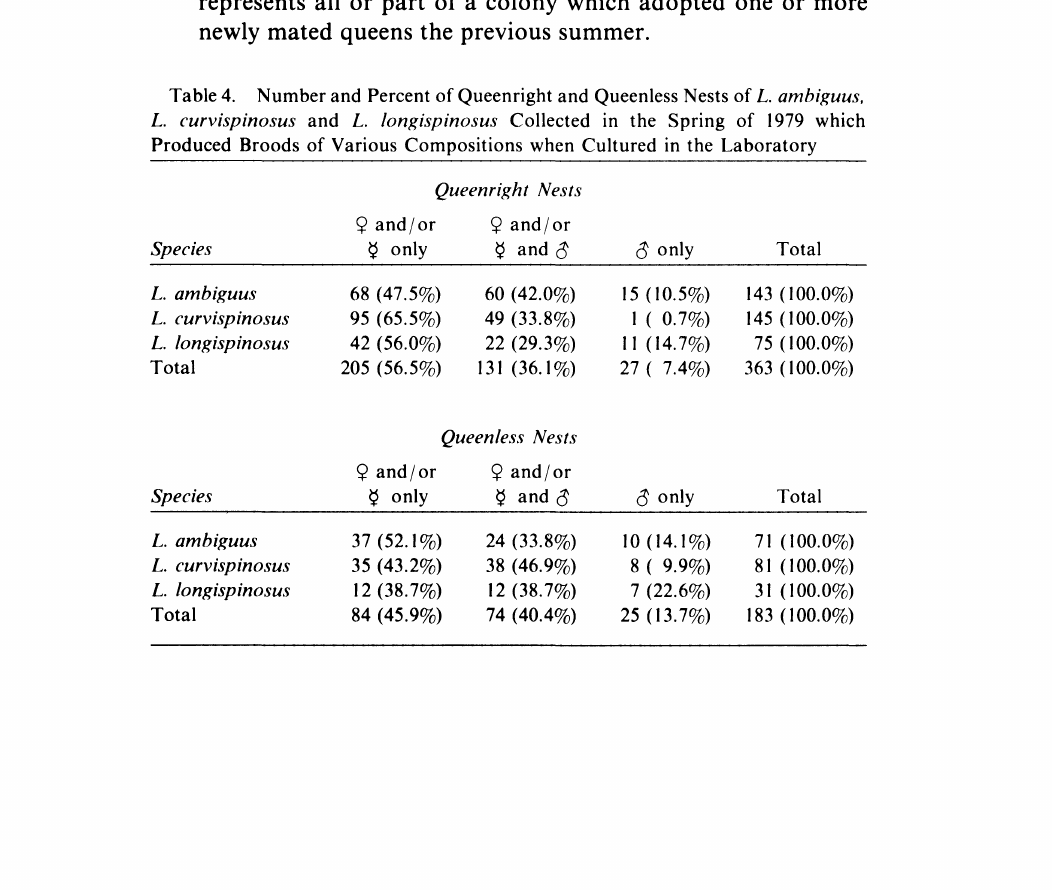
Table 4. Number and Percent of Queenright and Queenless Nests of L. ambiguus, L. curvispinosus and L. longispinosus Collected in the Spring of 1979 which Produced Broods of Various Compositions when Cultured in the Laboratory Queenright Nests and or and or Species only and only Total